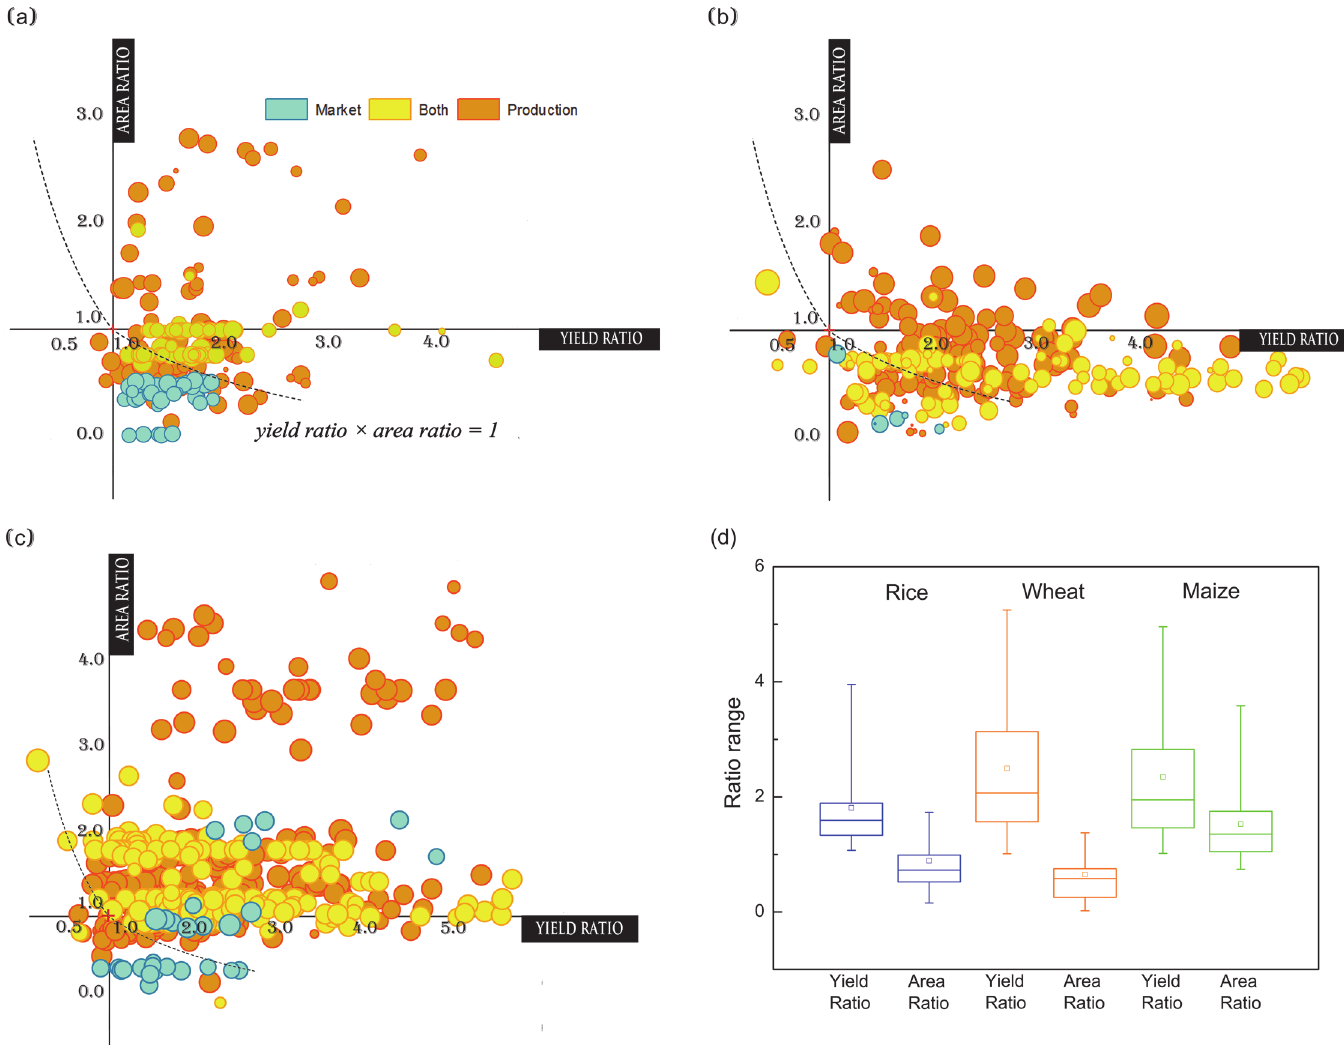
Fig 5. Static comparison in production between 1980 and 2008 of the main cereals. We compared the static change in yield, area and production for rice (a), wheat (b) and maize (c) undertaking different assignment of crop production and/or marketing, from 1980 to 2008. The horizontal and vertical axis shows changes in yield and area. Size of each circle shows the ratio of area in 2008 relative to 1980. Blue points denote counties assigned for marketing, while yellow points for both production and marketing, and orange for production. The ratio greater than 1 implies an increasing trend in yield or area. If the ratio is less than 1, yield or area has decreased from 1980 to 2008. Change in production is expressed by the product of yield ratio multiplying area ratio. Dots above the dotted line imply increasing production from 1980 to 2008. The statistical relationships of yield and area ratio among the three cereal crops are illustrated in figure